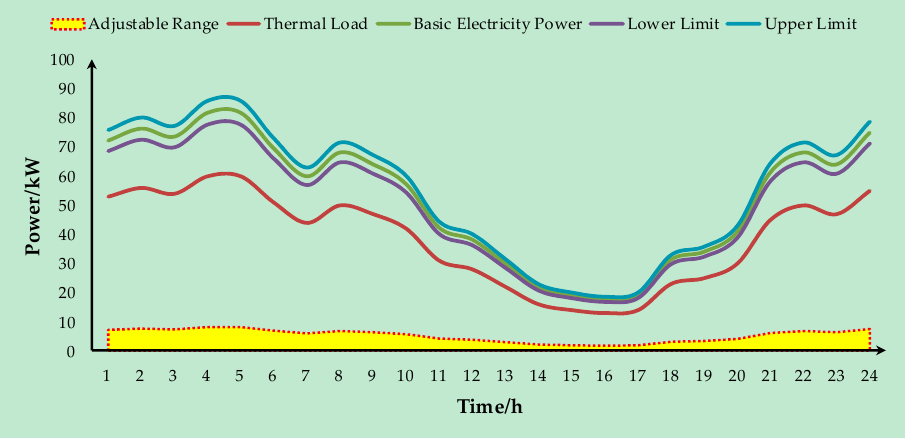
Figure 3. Modified dispatch strategy for MT’s CCHP mode.